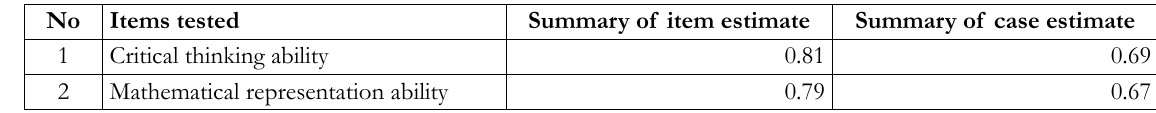
Table 5. Result of the analysis of the reliability of critical thinking and mathematical representation ability test items